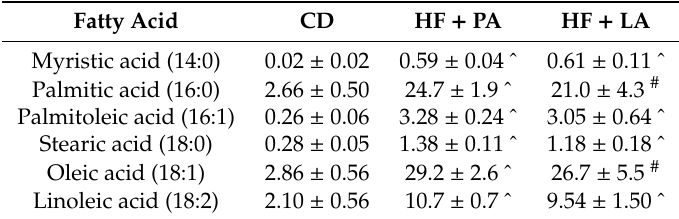
Table 2. Fatty acid profile in liver triglycerides.